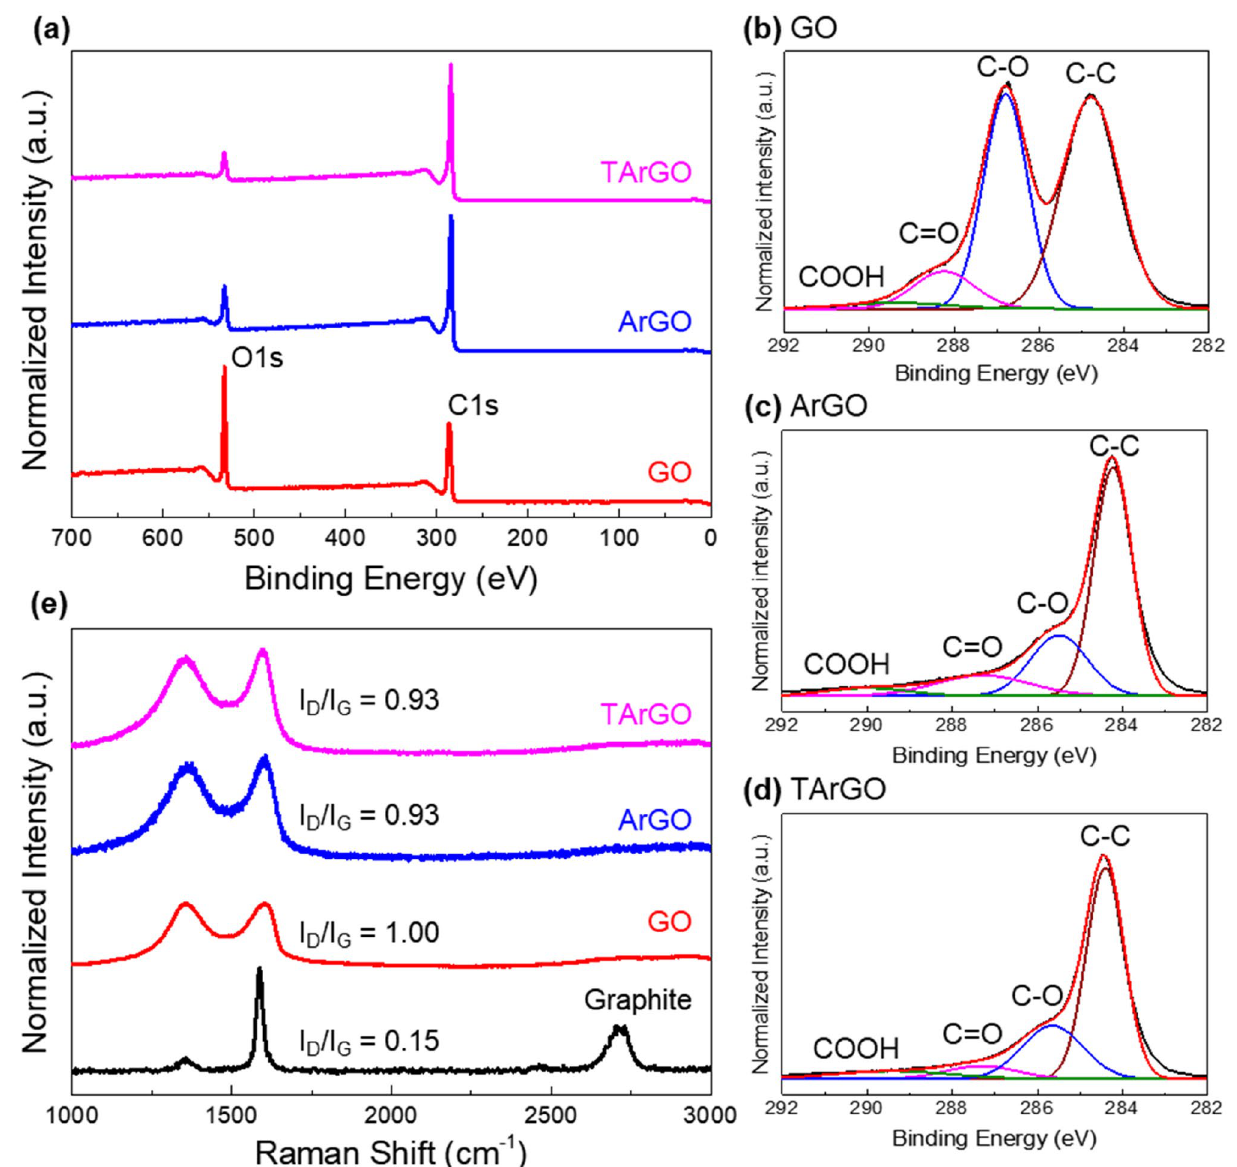
Figure 2. Chemical properties of Graphene oxide (GO), activated reduced GO (ArGO), and thermally treated ArGO (TArGO). ( a ) X-ray photoelectron spectroscopy survey scan of GO, ArGO, and TArGO. ( b–d ) XPS C 1 s spectra of GO, ArGO, and TArGO, respectively. ( e ) Raman spectra of graphite, GO, ArGO, and